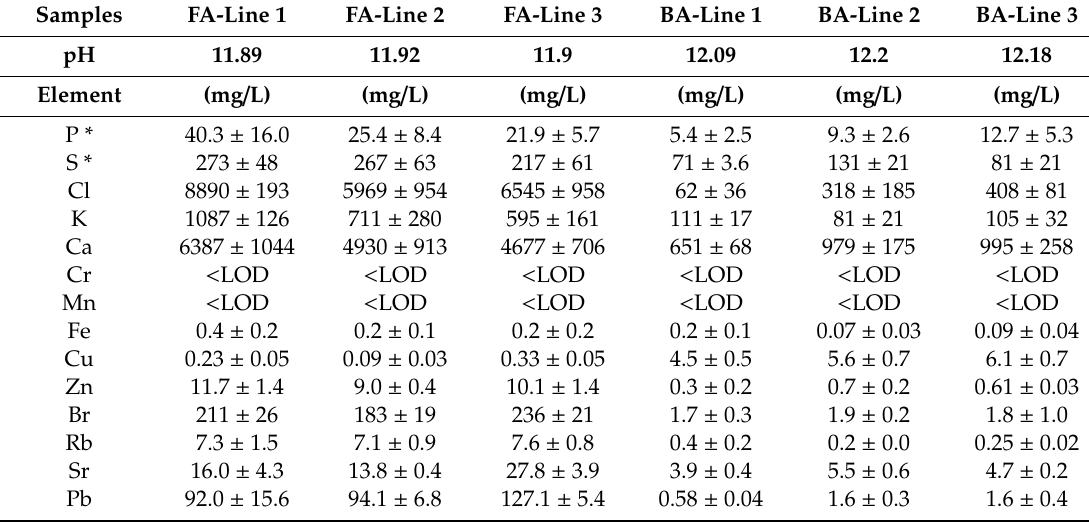
Table 2. Results of the Total-reflection X-ray Fluorescence (TXRF) analysis and pH values of leachate solutions of Sewage-MSWI FA and Sewage-MSWI BA derived from di ff erent combustion